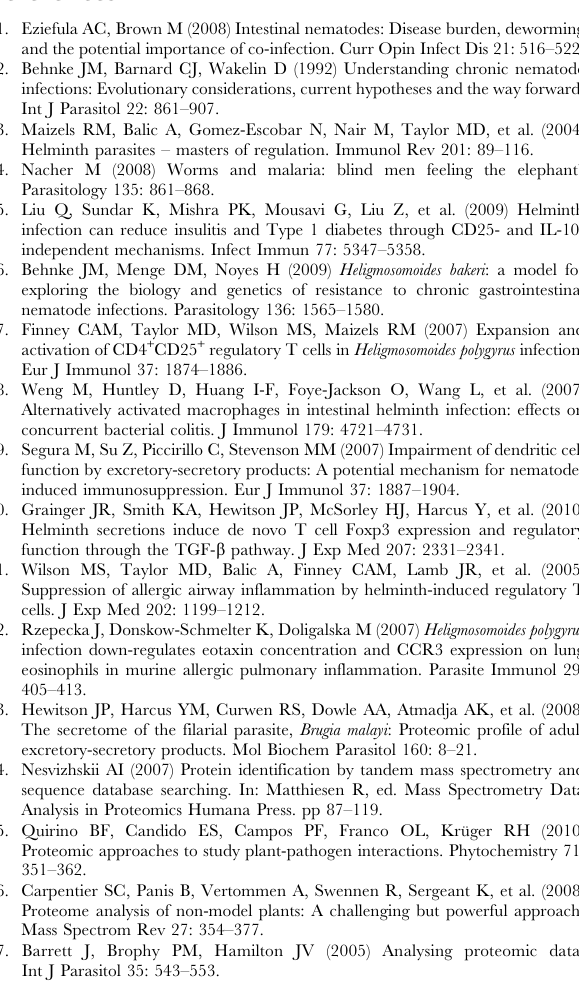
Table S2 H. polygyrus RNA-seq assembly automated annotation. (PDF) Table S3 Proteins identified in ESP from H. polygyrus through search on conceptual translation from RNA-seq assembly. Table S4 Enrichment analysis of GO terms in the ESP dataset when compared to the transcriptome dataset. Table S5 Enrichment analysis of InterPro domains and families in the ESP dataset versus the transcriptome